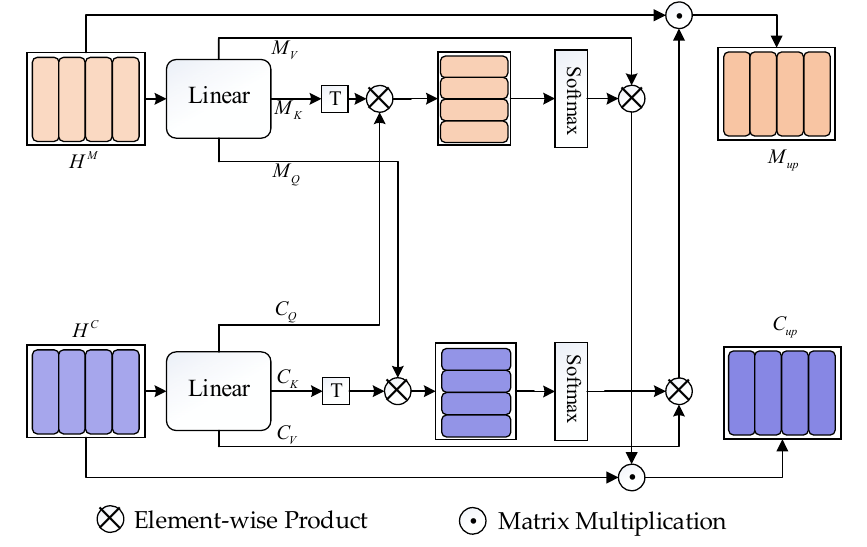
Figure 3. Cross-Attention module.